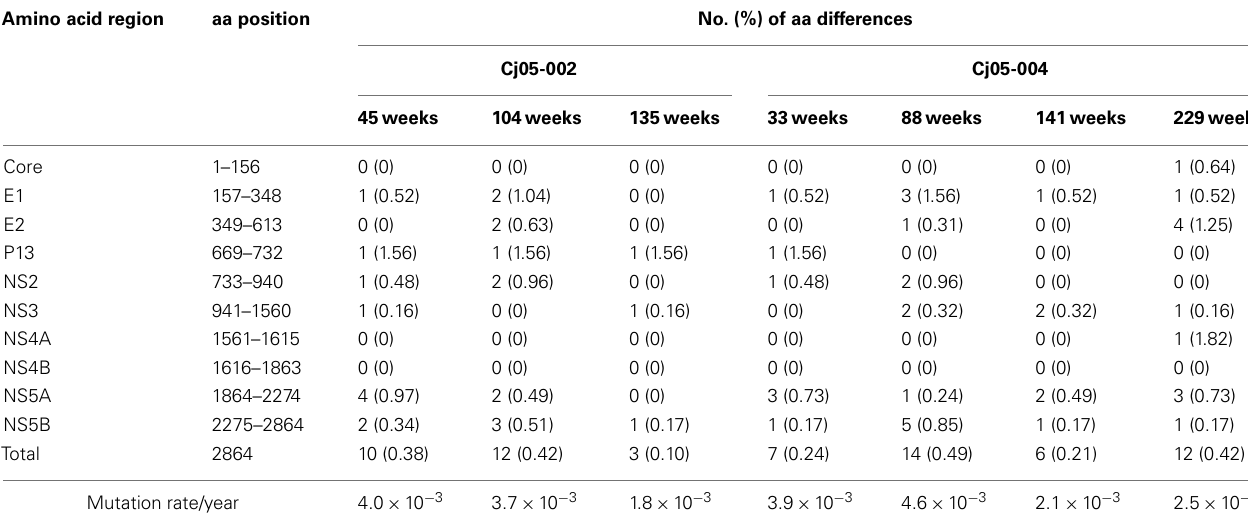
Table 2 | Summary of the amino acid substitutions in GBV-B genome sequences amplified from plasma of the marmosets persistently infected with